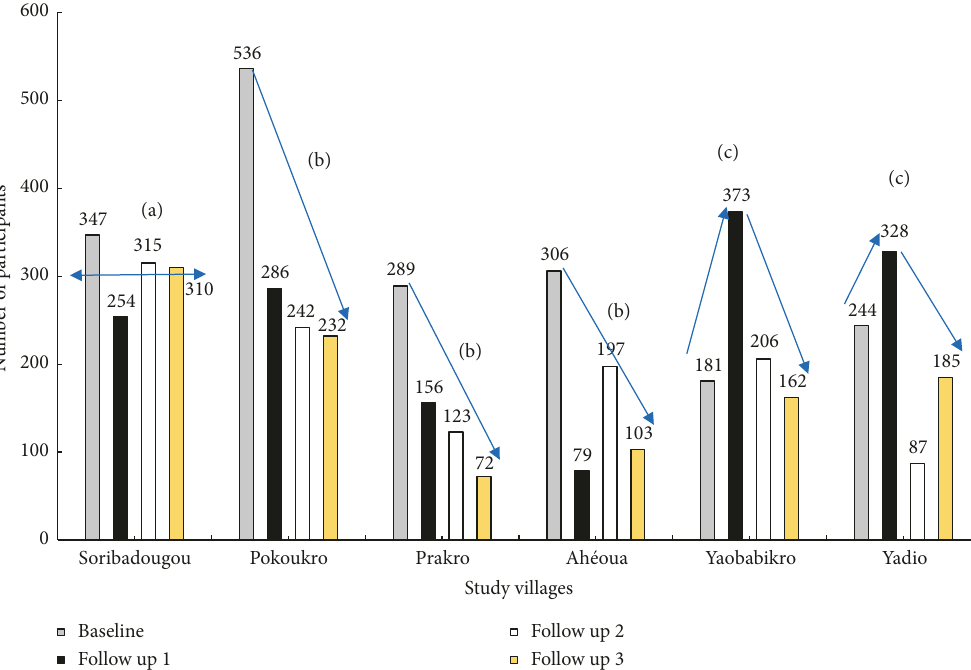
Figure2:ParticipationovertimeforintestinalparasitologicalexaminationsineasternsettingsofCˆoted’Ivoire.(a)Relativelyconstantnumber of participants. (b) Significant decrease in the number of participants. (c) Bell-shaped evolution in the number of participants with a peak at first